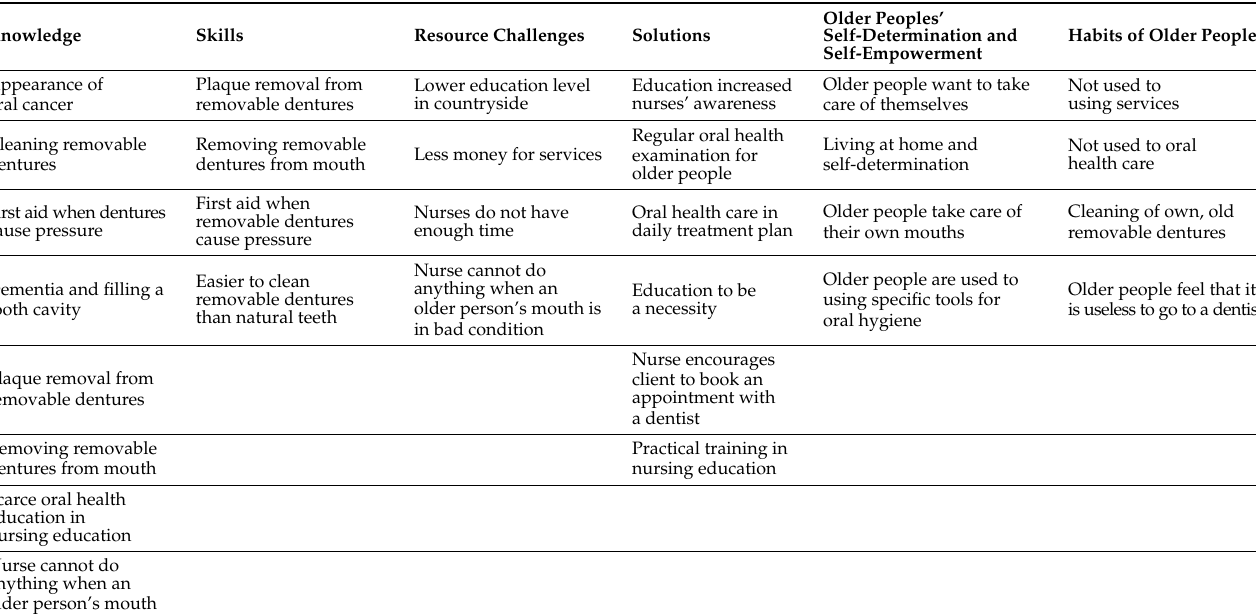
Table 6. Open codes of